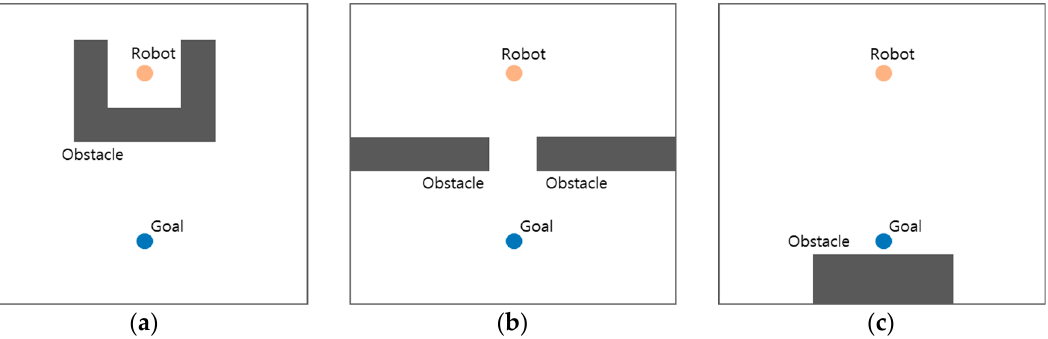
Figure 2. Representative local minima in a potential field: ( a ) the robot is surrounded by obstacles and the exit is opposite the goal; ( b ) narrow distance between obstacles; and, ( c ) the goal is very close to the obstacles.